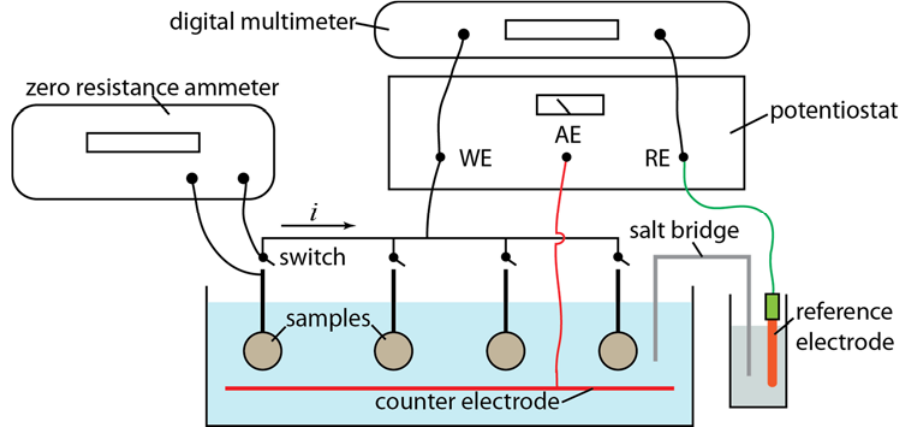
Figure 1. Schematic layout of the